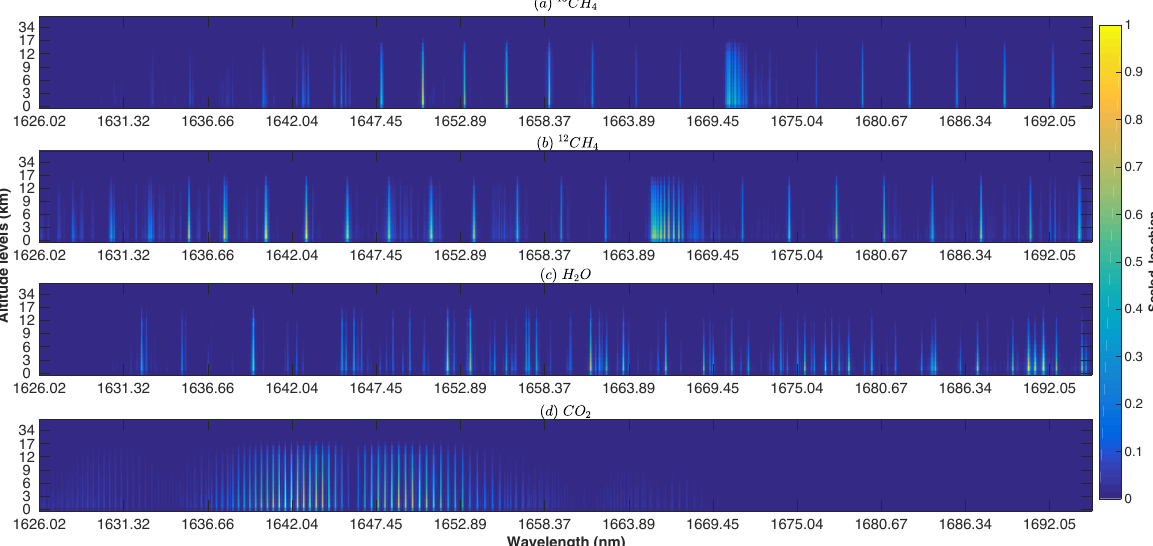
Figure 3. Normalised sensitivity (between 0 and 1) of GOSAT-2 measured radiance with respect to a variation of 1% of the concentration of the main constituent gases in the 1626–1692nm (band 2) wavelength range; 13 CH 4 (a) , 12 CH 4 (b) , H 2 O (c) and CO 2 (d) . All calculations were performed using the ORFM RTM, assuming a solar zenith angle of 30 ◦ , a viewing zenith angle of 0 ◦ and a surface albedo of 0.1, in conjunction with the HITRAN2012 database and the University of Leicester model MIPAS